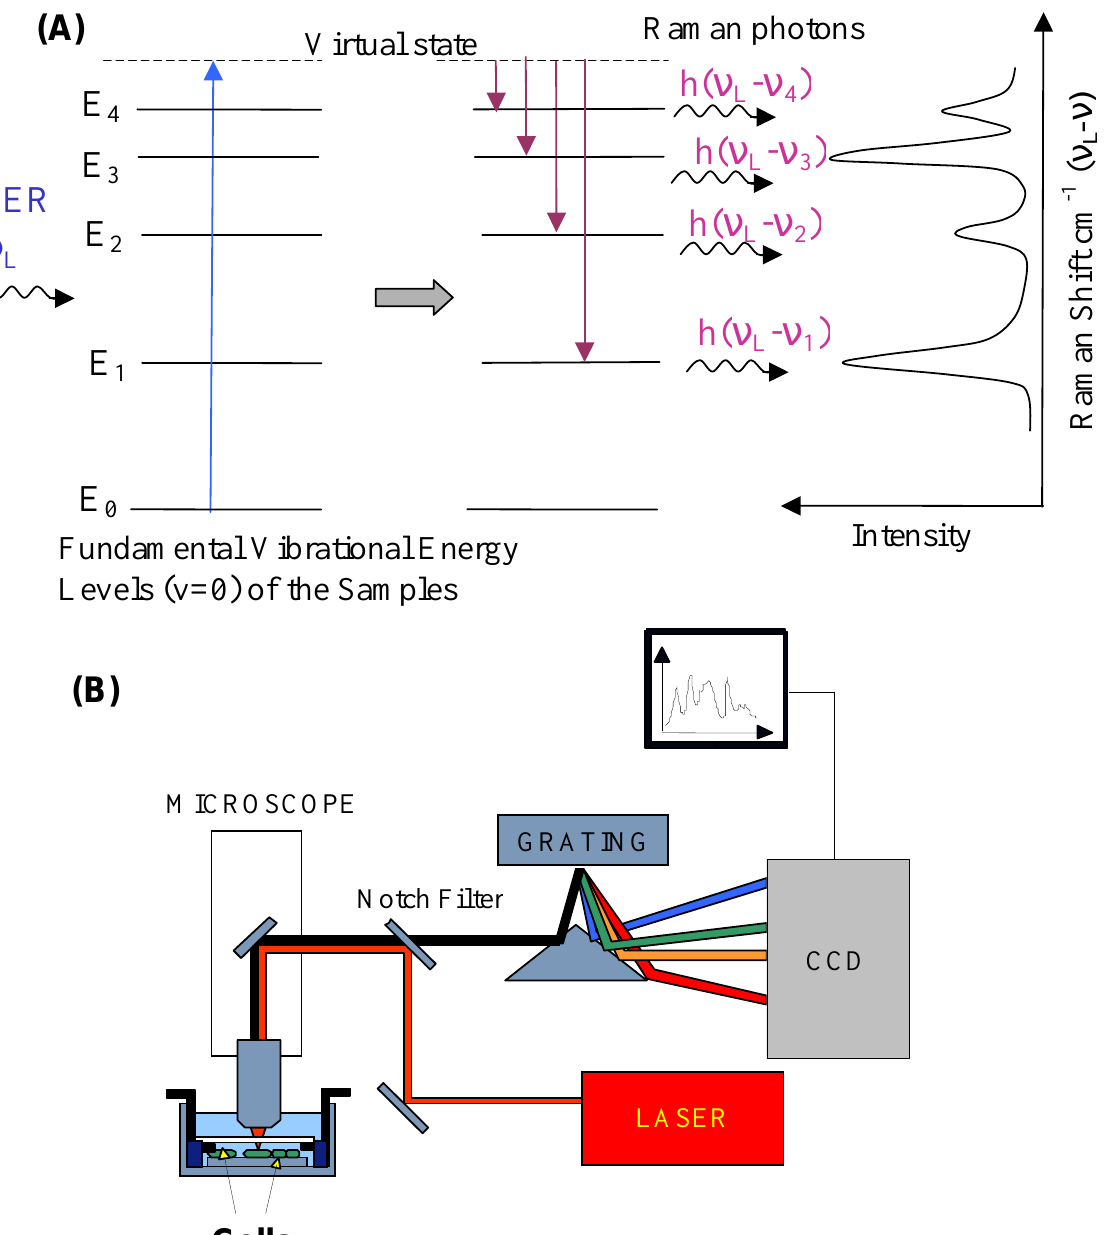
Figure 1 . Schematic representation of (A) Raman Stokes scattering of laser photons by vibrating molecules in the sample: energy is transferred by laser photons to the molecules as vibrational energy, the energy loss correspond to the vibrational energy levels of the molecules (E1, E2, …); and (B) experimental set-up for Raman spectroscopy measurements of